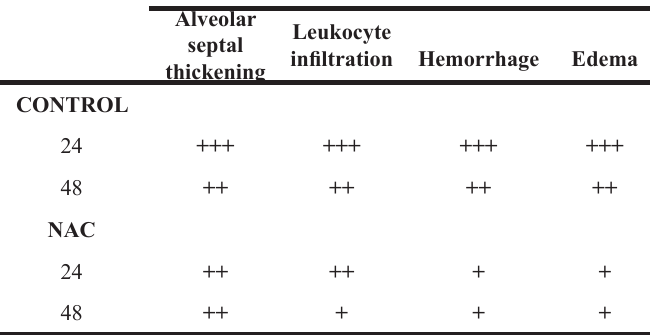
TABLE 2 - Qualitative analysis of lung damage tissue or cell signs found in the slides stained with HE.